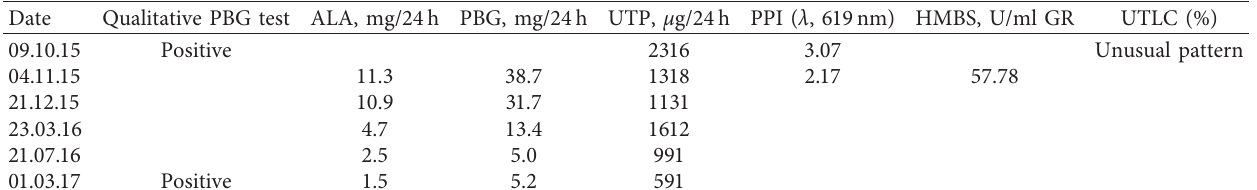
Table 2: Biochemical analyses in the son.